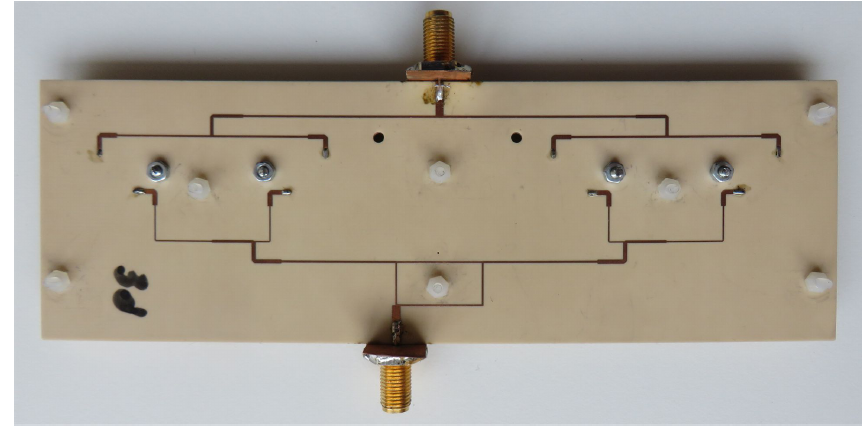
Figure 17. Fabricated antenna array—bottom view.